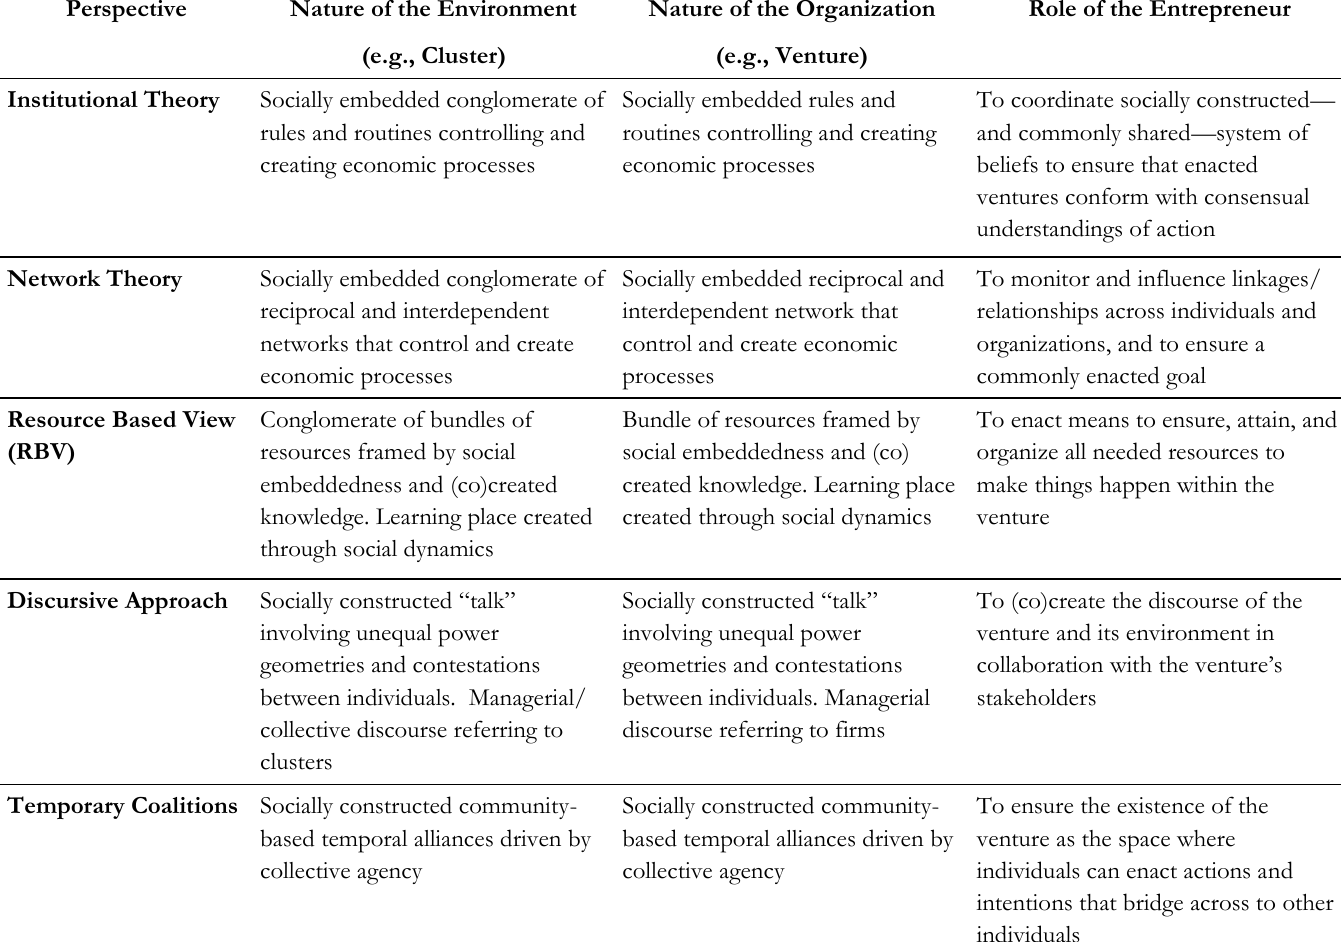
Table 2. Socioeconomic